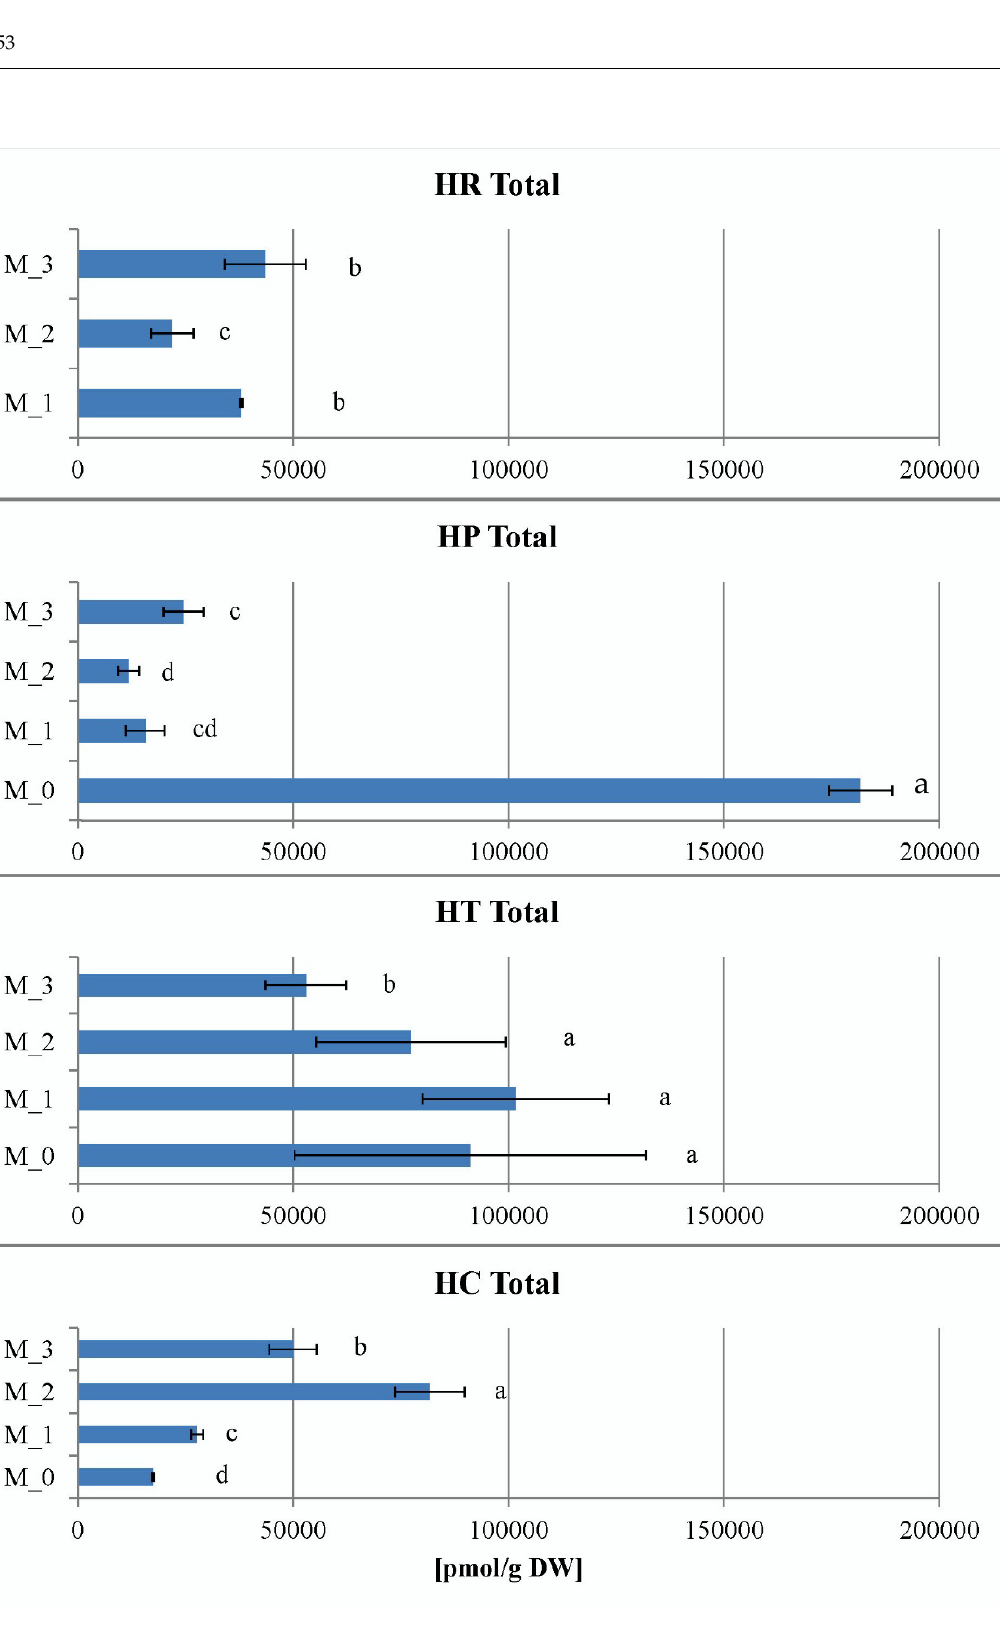
Figure 7 . Total sum of salycilic acid (SA) and benzoic acid (BA) in the four Hypericum species in M_0—PGR-free, M_1—0.2 mg/L BA, M_2—0.2 mg/L BA + 0.1 mg/L IBA and M_3—0.1 mg/L BA + 0.2 mg/L IBA supplemented media. HR– H. richeri Vill., HP– H. perforatum L., HT– H. tetrapterum Fries. and HC– H. calycinum . Same letters indicate statistically non-significant and different letters indicate statistically significant differences in mean values when comparing the parameter between all samples.